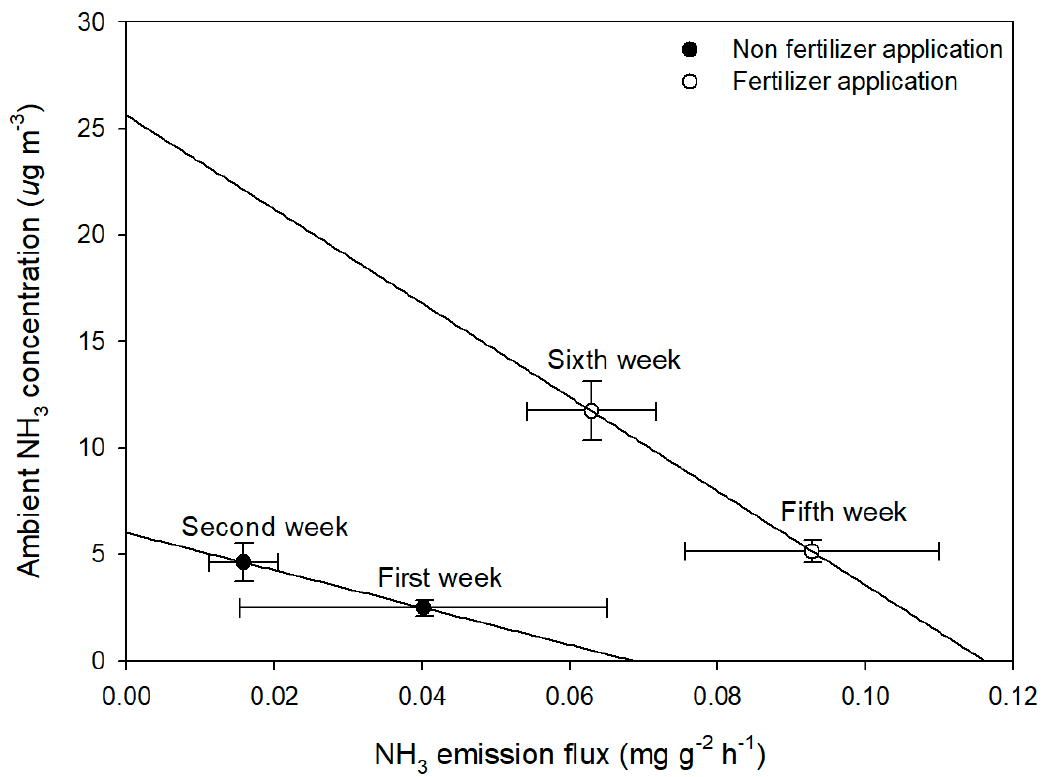
Figure 6. Relationship between NH 3 emission flux by chamber experiment at lab scale and ambient NH 3 concentration by passive sampler experiment at field scale.